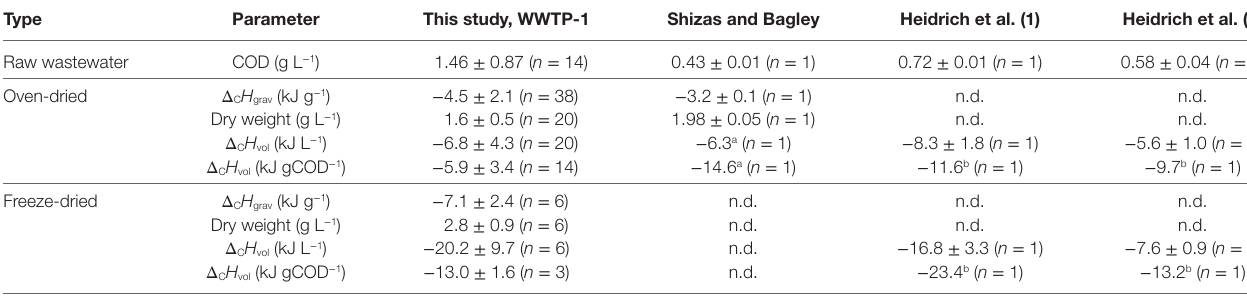
TaBle 2 | Summarizing the heat of combustions and COD of wastewater derived from this and previous studies.